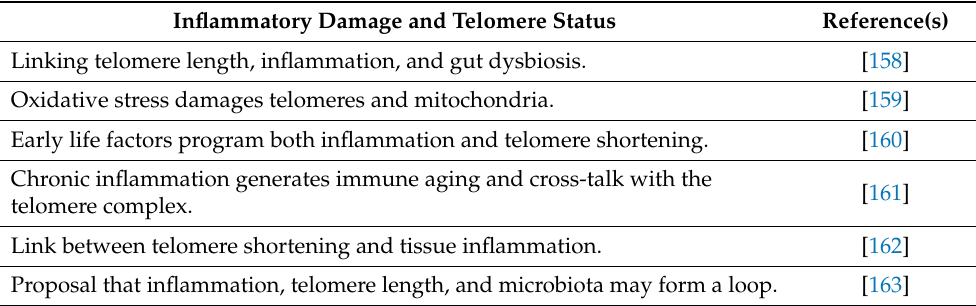
Table 8. Inflammation, Oxidative Damage and Telomere